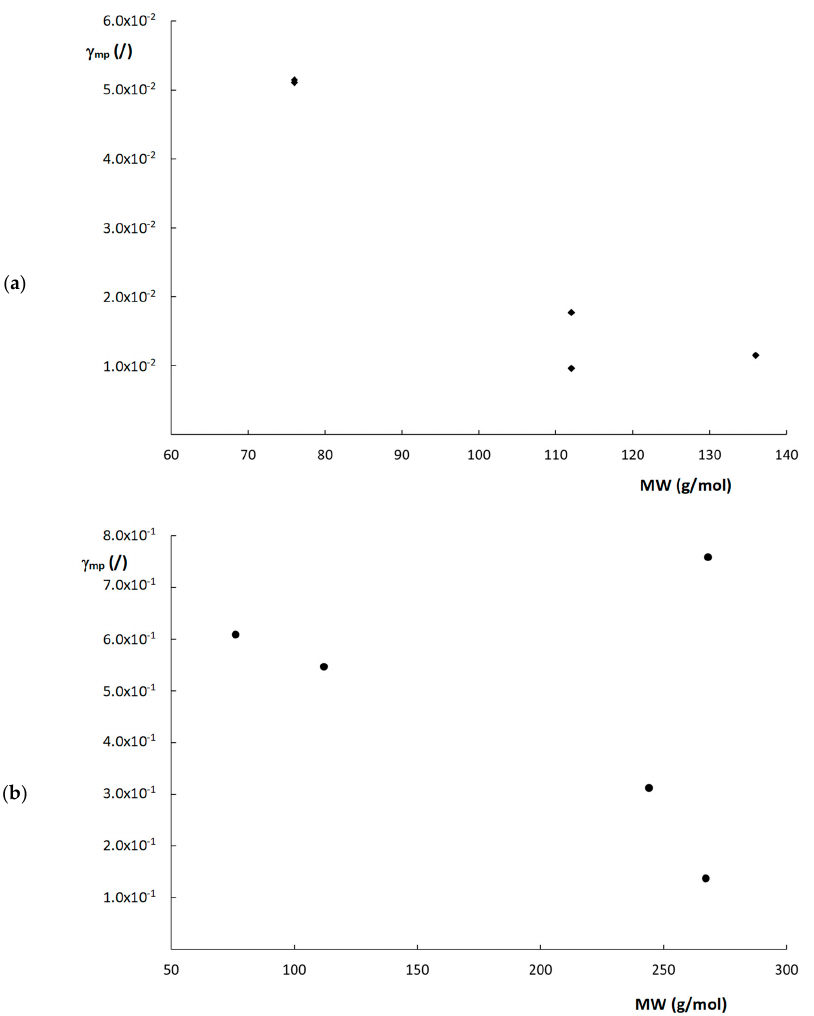
Figure 6. Plots of γ mp versus MW for the ( a ) poly(SPE-co-EDMA) monolithic column and ( b ) poly(SPE-co-MBA) monolithic column. Note that using Equations (22) and (23), every experimentally obtained datapoint of u 0 versus H is converted into a measure of the time that is required to obtain a certain plate count when operating the column at the maximum pressure, and at the correspond- ing velocity u 0 . In this way, each datapoint of t 0 versus N is in fact obtained in a different column length, where low values of u 0 will typically be obtained in long column lengths and hence result in high N-values, while high u 0 -values will typically be obtained in short column lengths and hence result in lower N-values. Kinetic plots for the columns evaluated in this work were constructed for the com- pound with k” ∼ 2 and for a maximum pressure Δ P max = 200 bar and are shown in Figure 7. The compound with k” ∼ 2 was the same for all columns (uracil) and was purposely chosen to avoid any bias on the column performance that might be due to MW effects. The plots